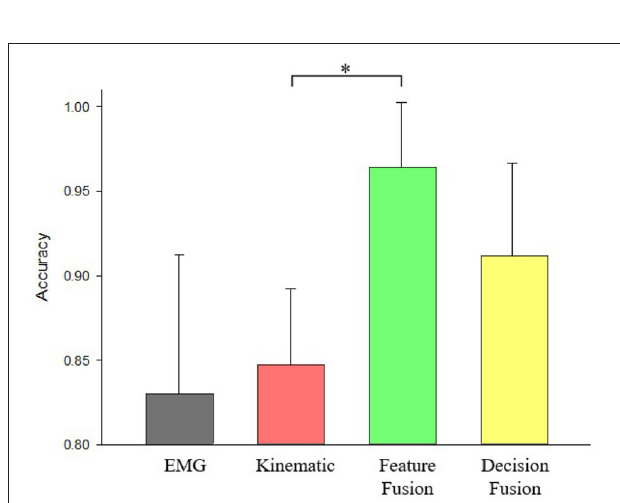
FIGURE 7 | Accuracy comparisons of pattern recognition using EMG only, kinematics only, feature fusion of kinematics + EMG, and decision fusion of kinematics + EMG for post stroke patients. * Denotes p <